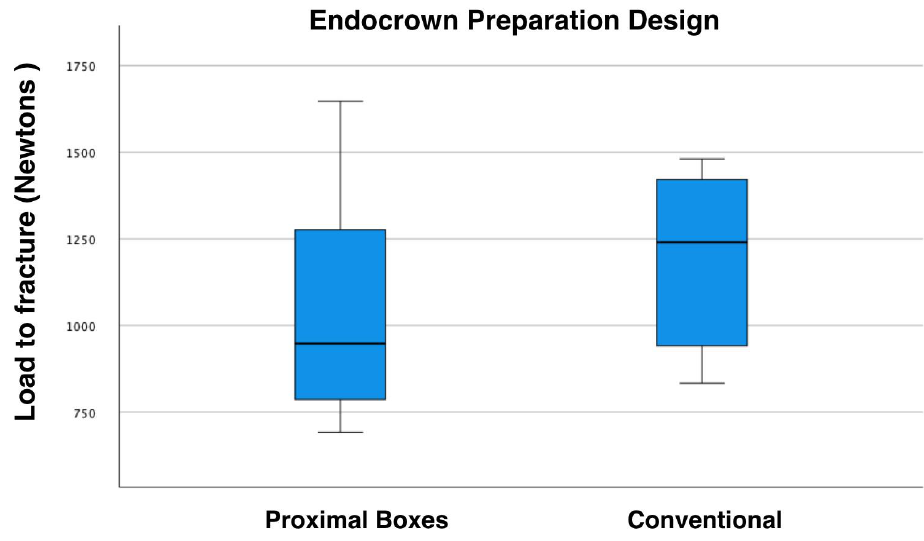
Figure 4. Analysis of endocrown designs’ fracture resistance of conventional and proximal boxes.